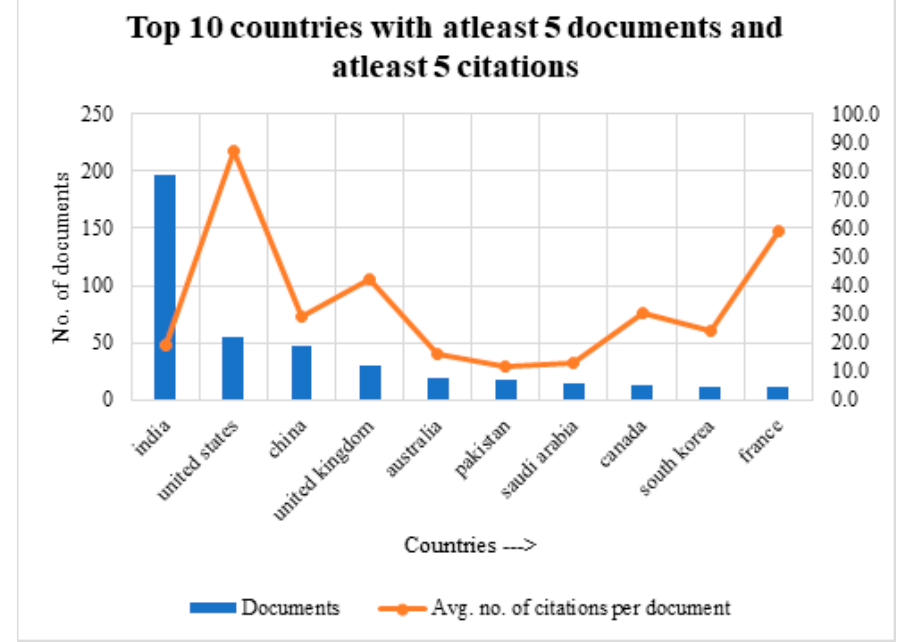
Figure 10. Number of documents published and citations received by the top 10 countries.